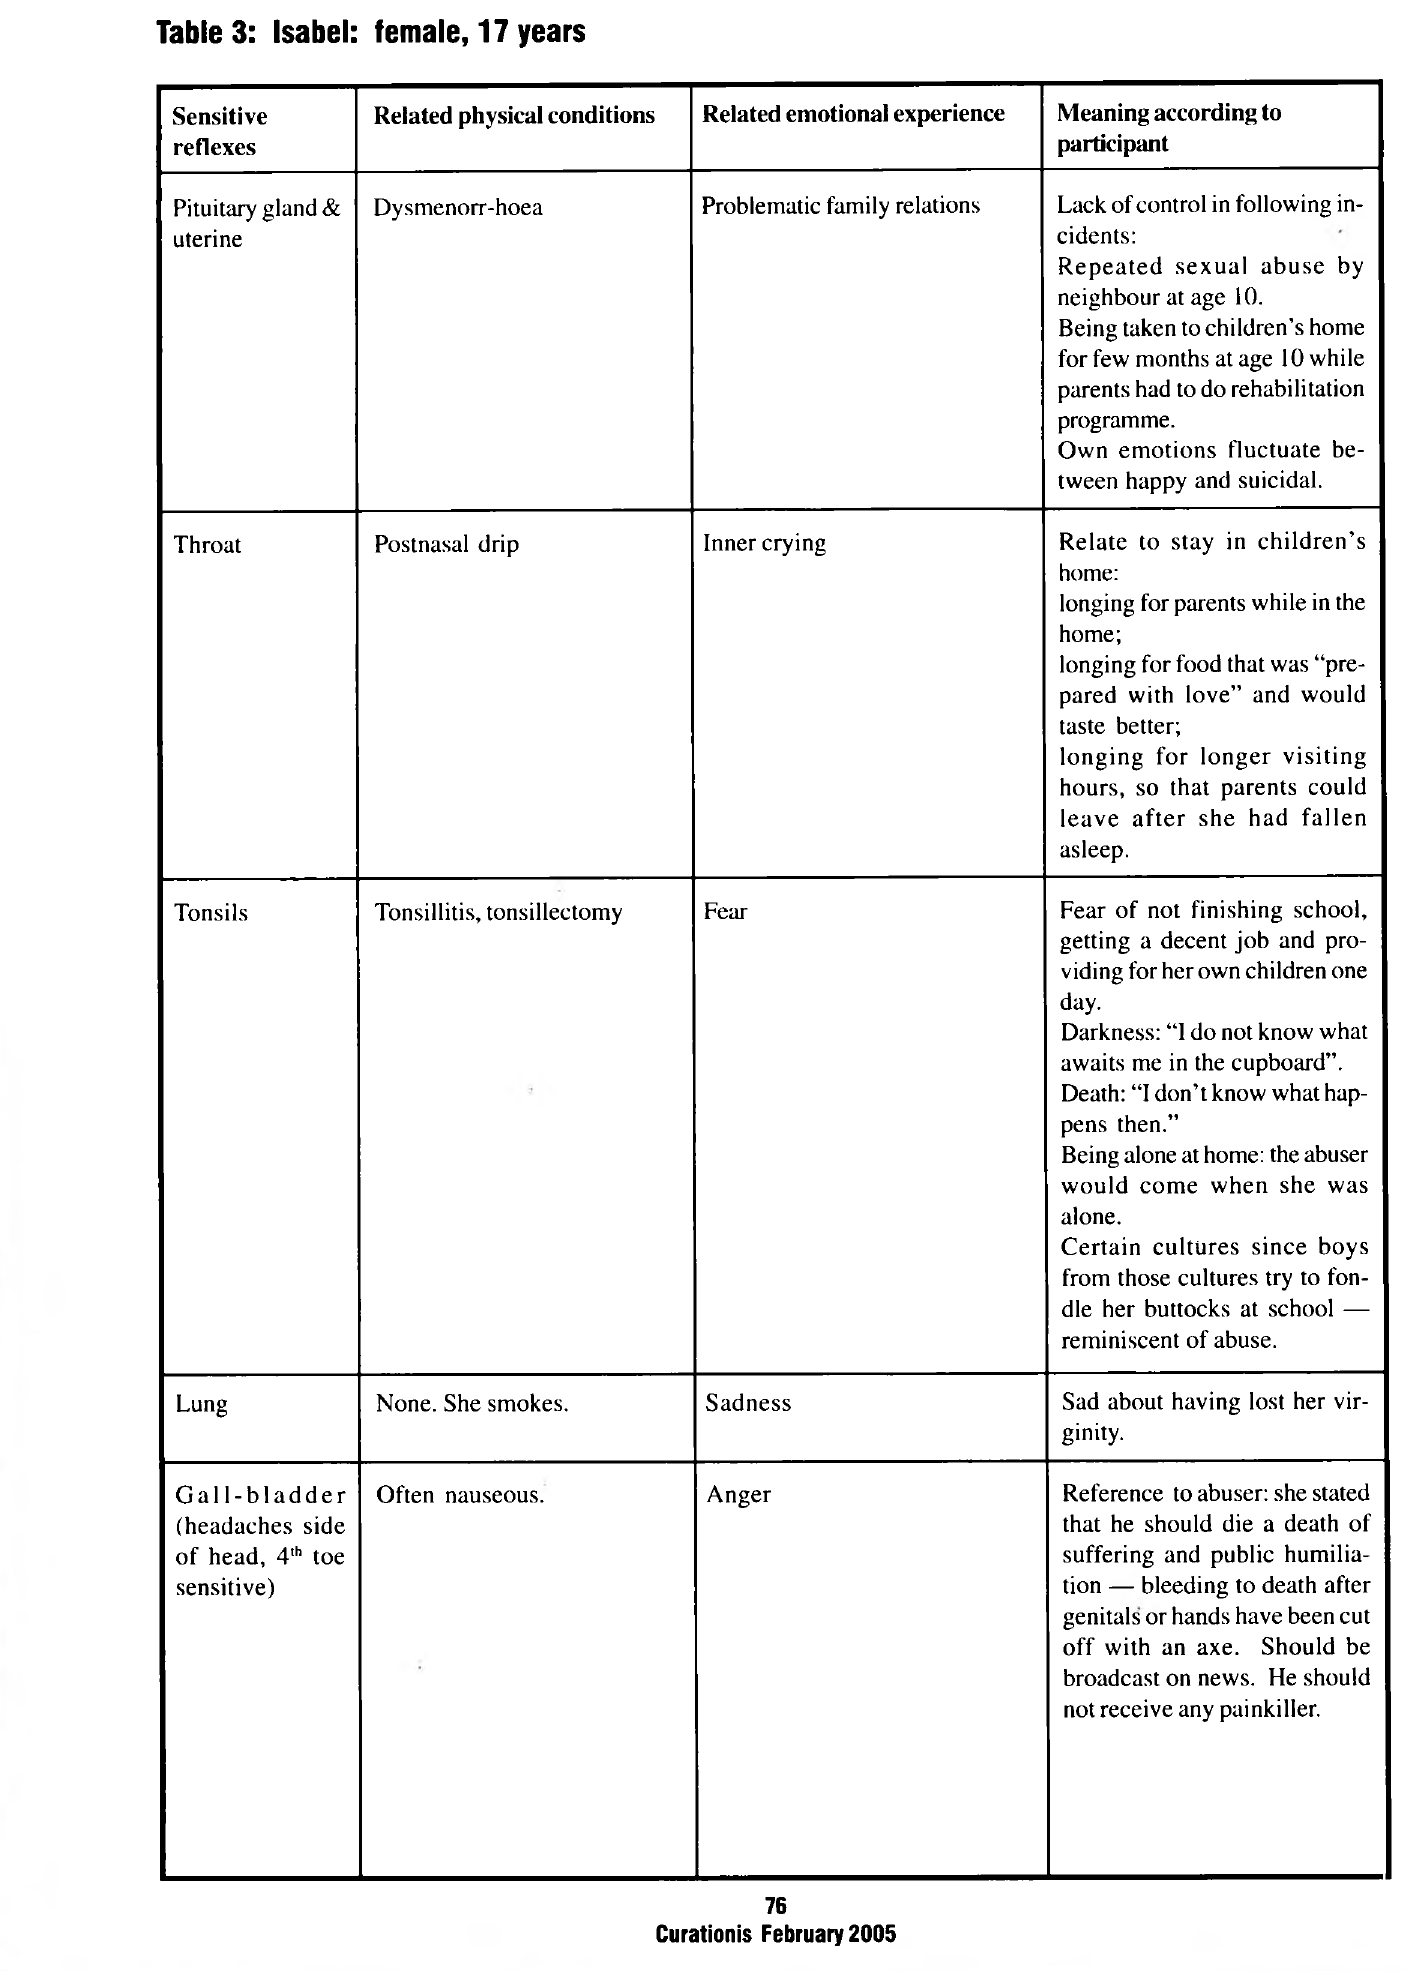
Table 3: Isabel: female, 1 7